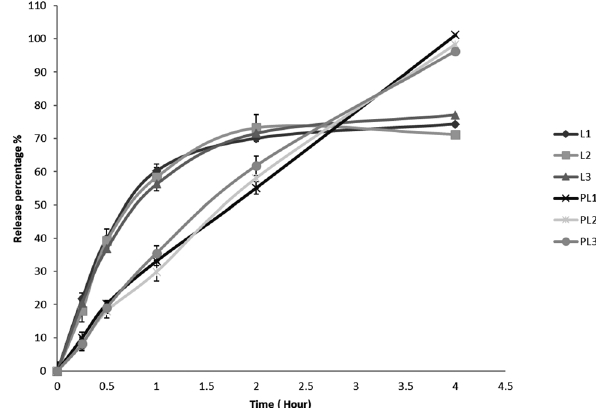
Figure 2: In vitro release pro fi le of cinnarizine from the liposomes and proliposomes in simulated gastrointestinal fl uids